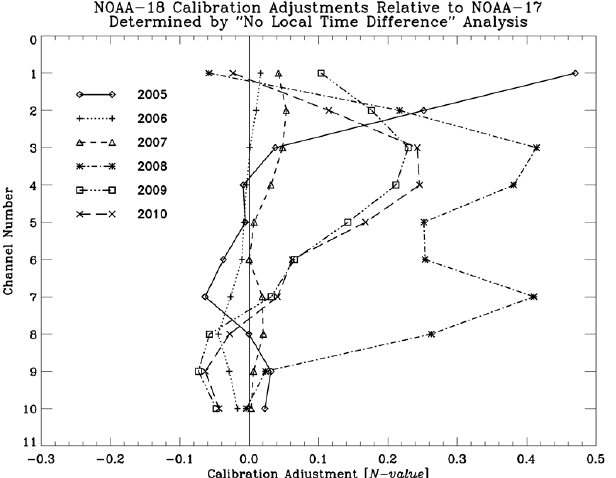
Fig. 9. Calculated intercalibration adjustments for NOAA-16 and NOAA-18 relative to NOAA-17, and for NOAA-14 relative to NOAA-16, based on “no local time difference” coincidence anal- ysis.